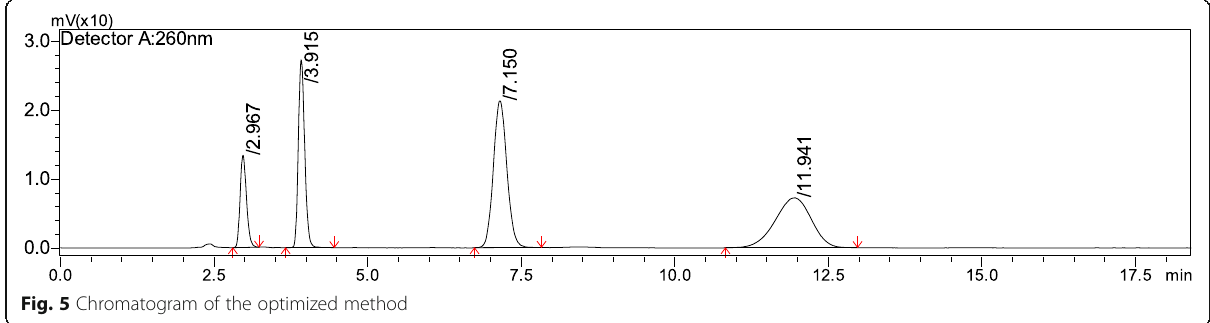
Fig. 5 Chromatogram of the optimized method